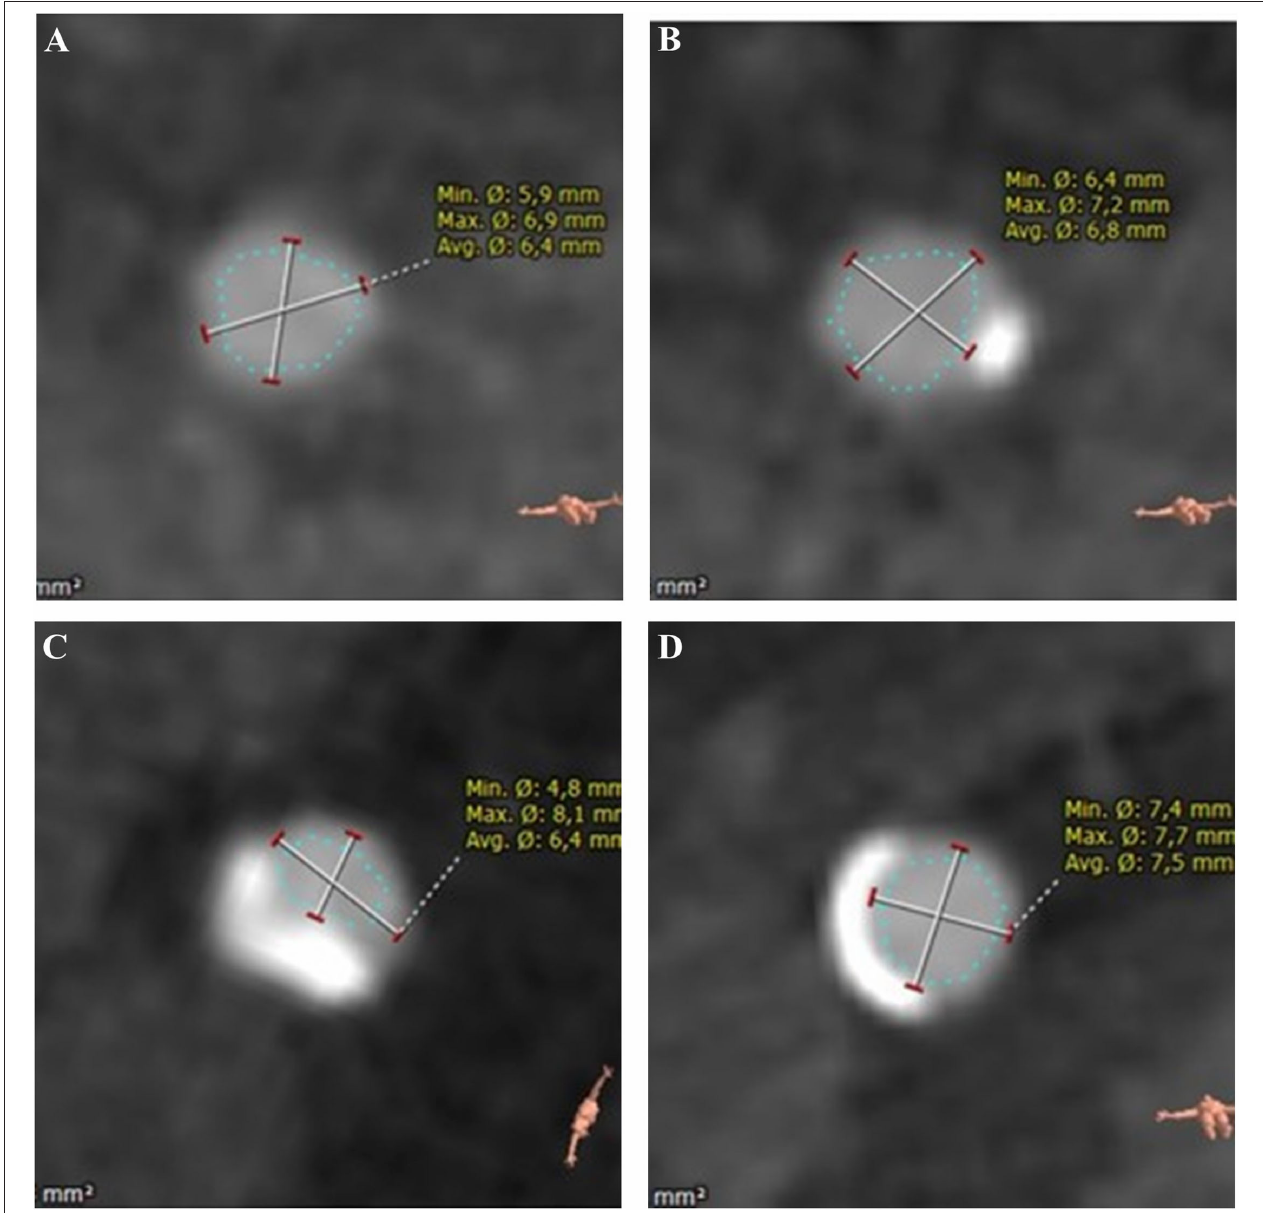
FIGURE 1 | Quantification of calcification of common femoral artery (derived from CT): none (A) mild (B) severe (C,D)